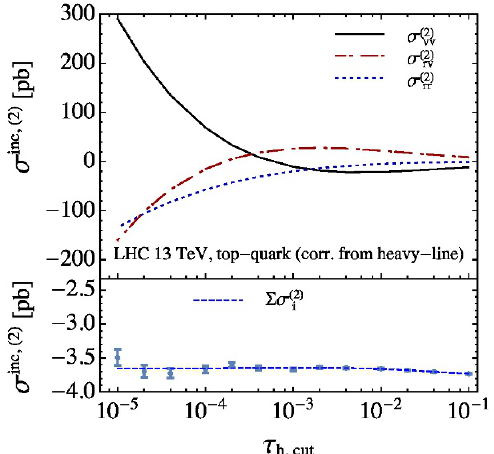
Figure 7 . Various components of the NNLO corrections from the heavy-quark line for the total inclusive cross section as a function of the cut-o(cid:11), for single top-quark production at 13